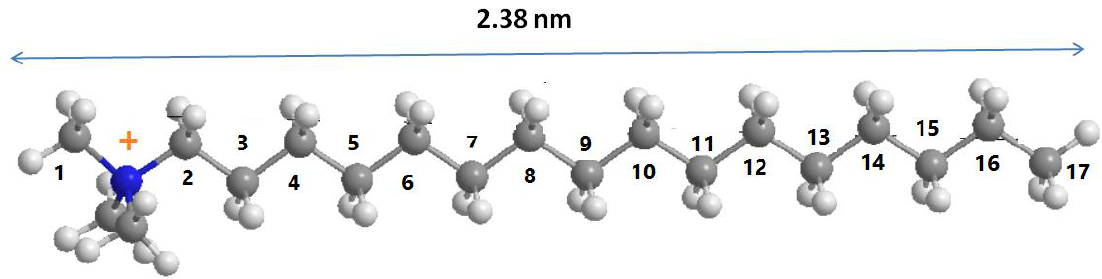
Figure 6. The optimized three-dimensional structural formula of the C16TMA cation.